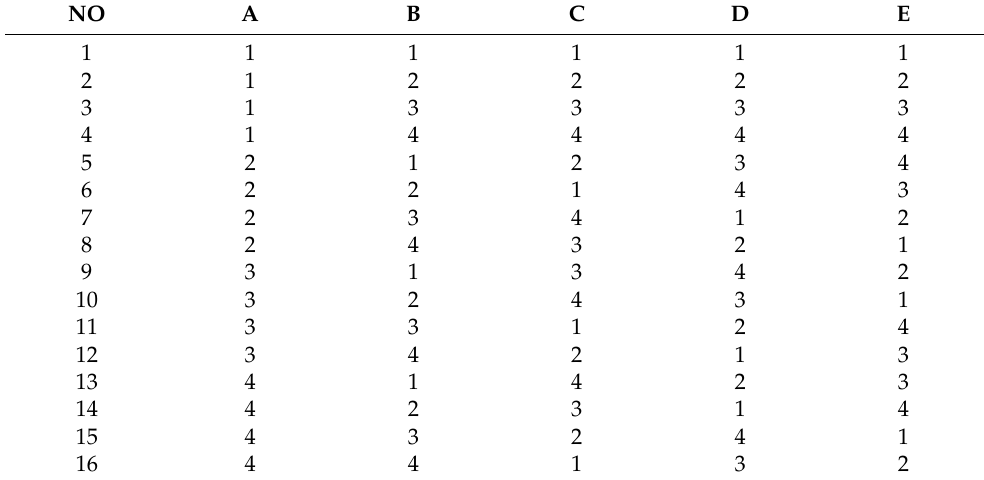
Table 3. The orthogonal